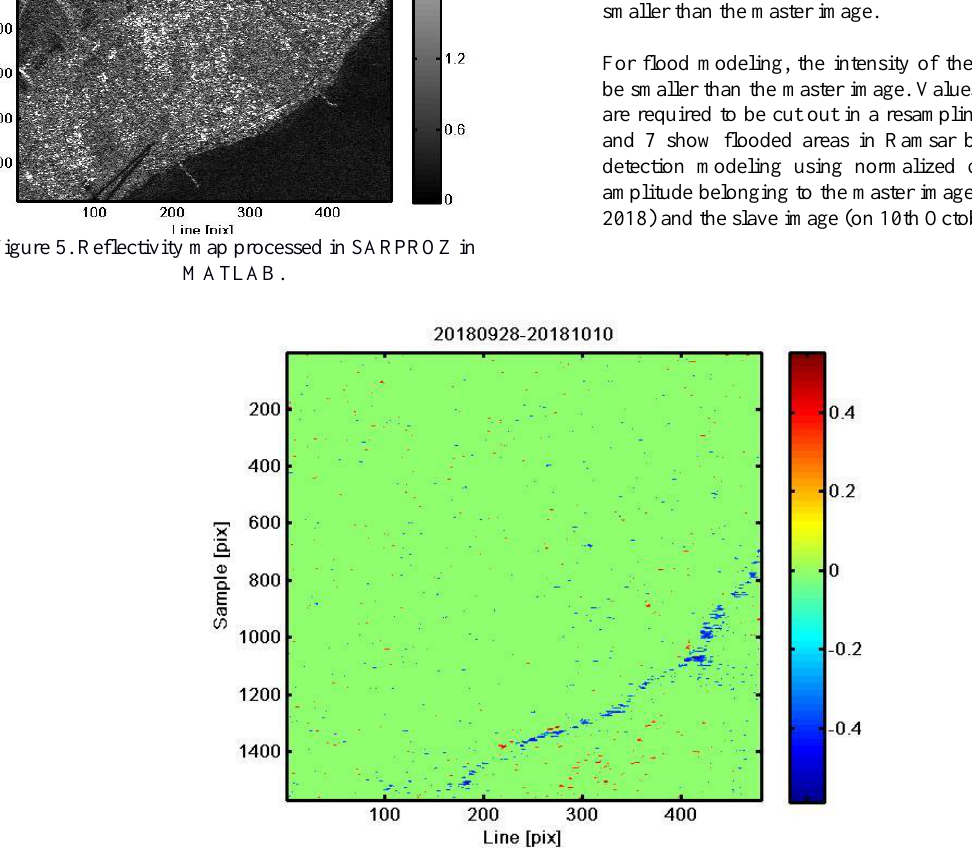
Figure 6. Change detection modelling from the normalized difference of amplitude values of the slave and the master images (blue color areas presents flooded regions).